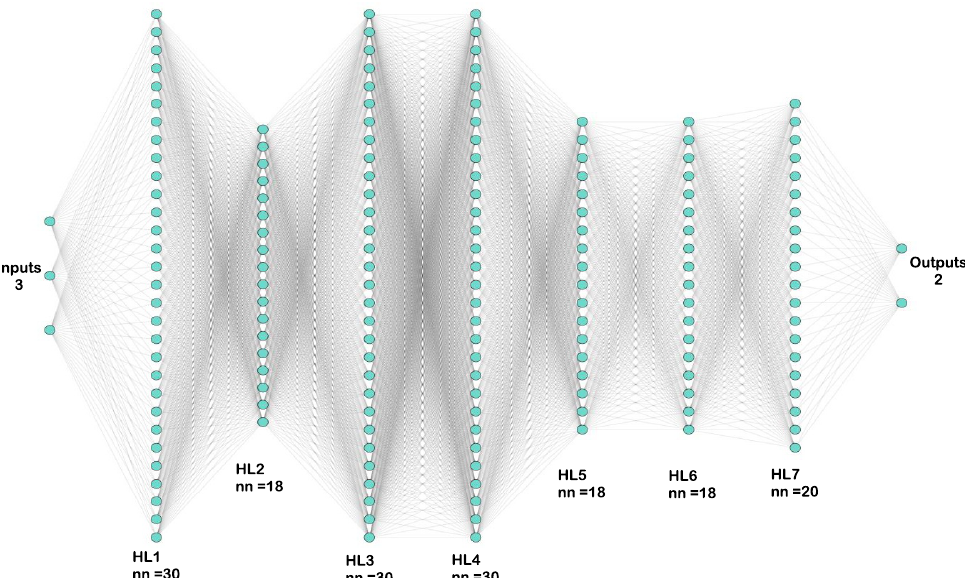
Figure 2. Deep neural network topology applied in this